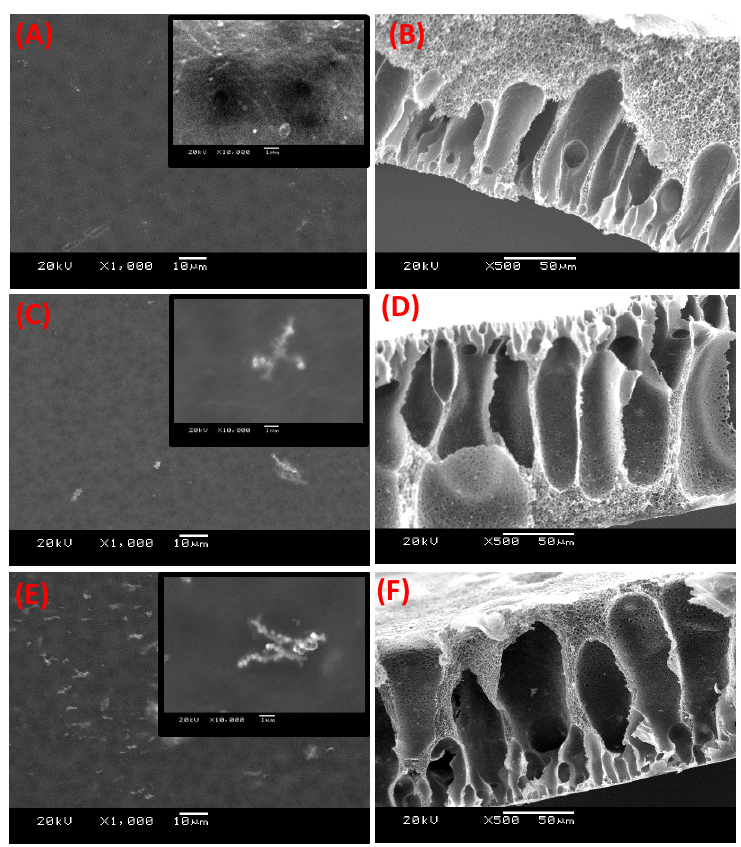
Figure 5. SEM images of the blank cellulose acetate (CA) ( A ) and magnetic mixed CA matrix membranes prepared using Fe 10 Ni 90 and Fe 20 Ni 80 alloys, respectively ( C , E ). Further, 0.1 wt.% of lithium chloride and 0.8 wt.% of poly(methyl methacrylate) (PMMA) were used. The images were taken at ×1000 and ×10000 magnifications. The SEM cross-sections of the blank CA ( B ) and magnetic mixed- CA matrix membranes prepared using Fe 10 Ni 90 and Fe 20 Ni 80 alloys, respectively ( D , F ), were imaged at ×500 magnification.